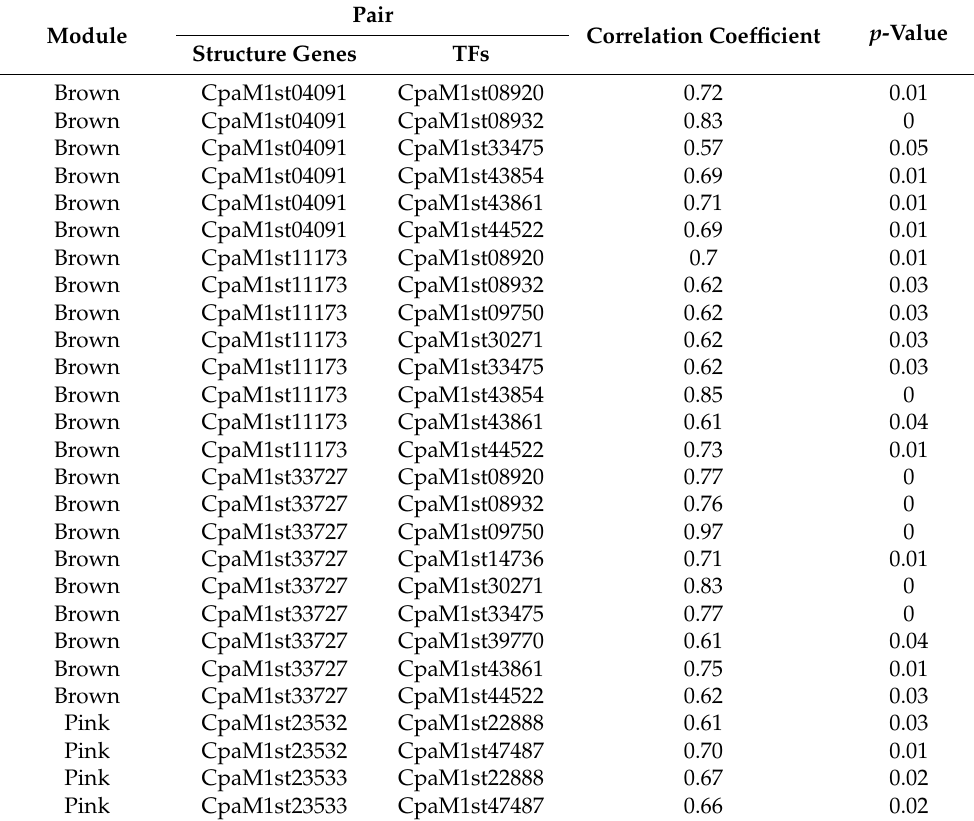
Table 2. Edge information for brown and pink modules’ positive regulatory networks.